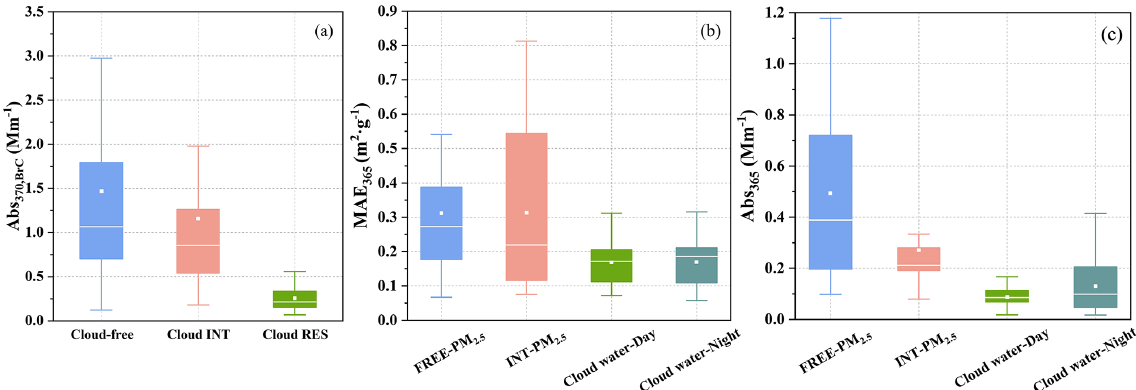
Figure 1. (a) The Abs 370 of cloud-free, cloud INT, and cloud RES particles, and (b) the MAE 365 and (c) Abs 365 of FREE-PM 2 . 5 , INT- PM 2 . 5 , cloud water-Day, and cloud water-Night.